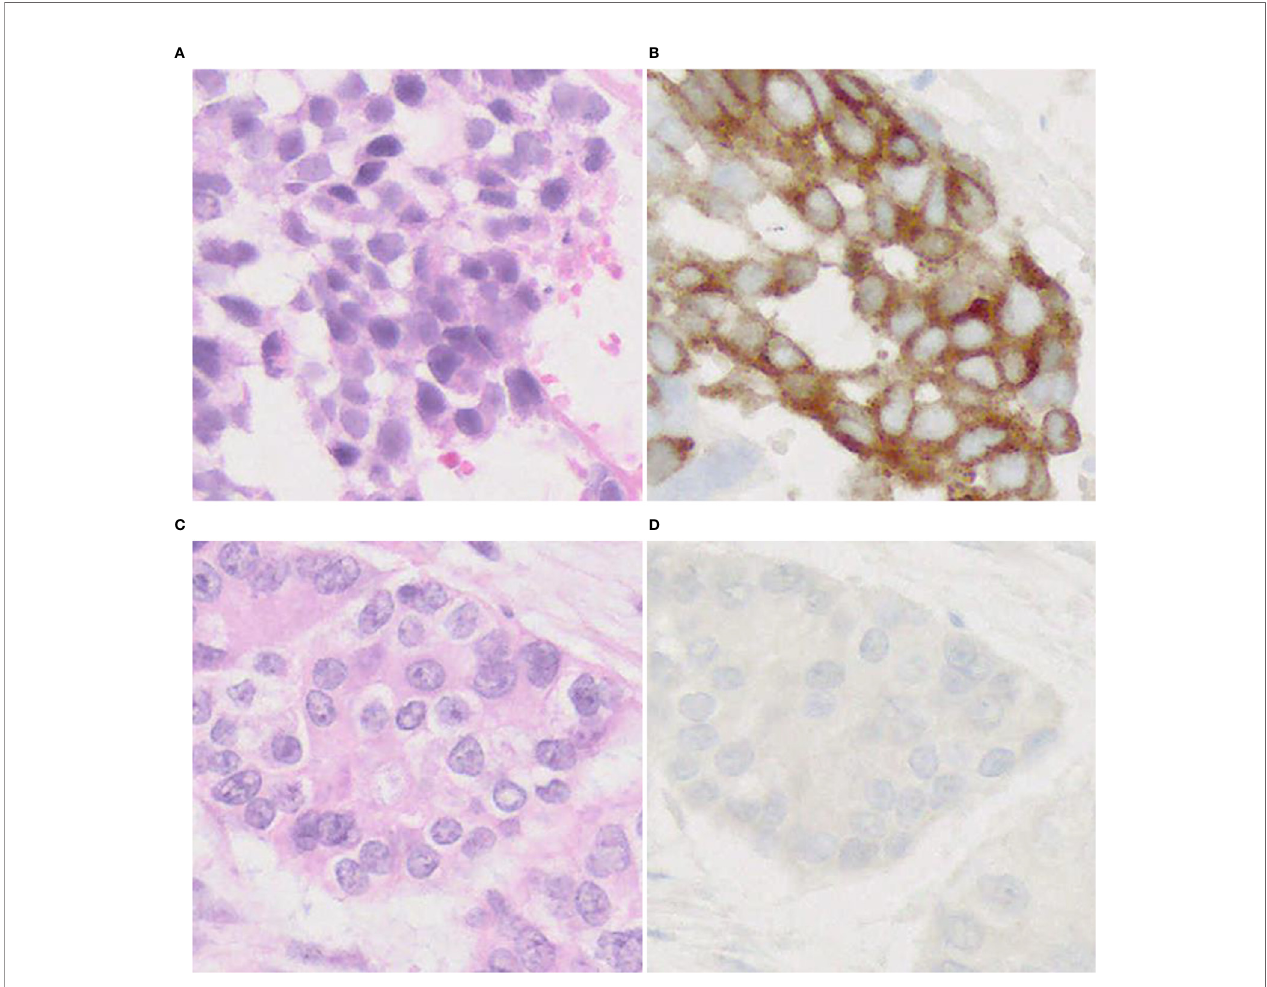
FIGURE 7 | DLL3 immunophenotype of LCNEC. Representative cases with positive (A, B) and negative (C, D) expression of DLL3. Note a cytoplasmic pattern of immunostaining (B) . Magni fi cation: ×40.